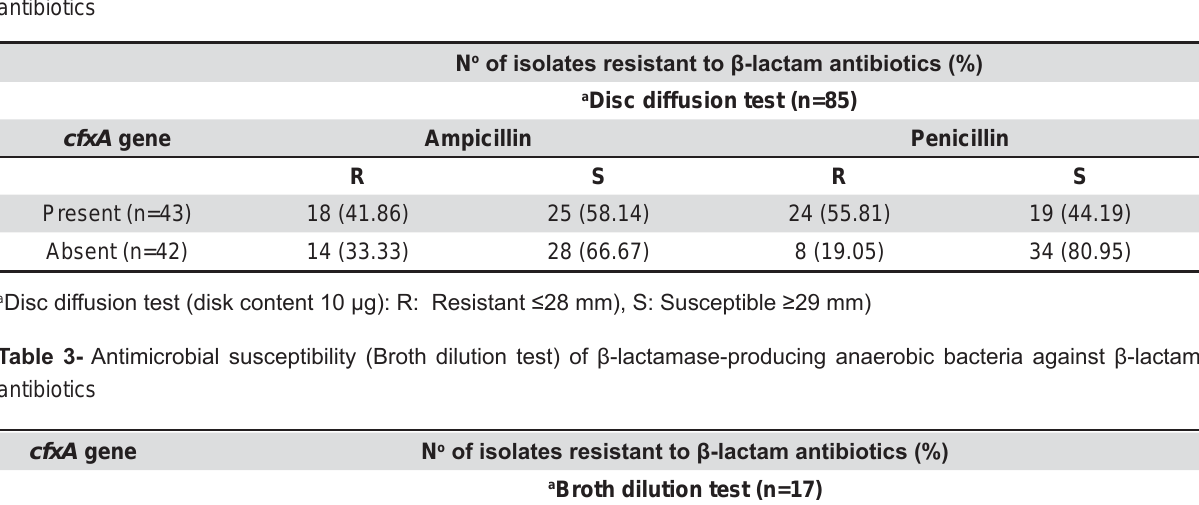
Table 2- (cid:3)(cid:36)(cid:81)(cid:87)(cid:76)(cid:80)(cid:76)(cid:70)(cid:85)(cid:82)(cid:69)(cid:76)(cid:68)(cid:79)(cid:3)(cid:86)(cid:88)(cid:86)(cid:70)(cid:72)(cid:83)(cid:87)(cid:76)(cid:69)(cid:76)(cid:79)(cid:76)(cid:87)(cid:92)(cid:3)(cid:11)(cid:39)(cid:76)(cid:86)(cid:70)(cid:3)(cid:71)(cid:76)(cid:73)(cid:73)(cid:88)(cid:86)(cid:76)(cid:82)(cid:81)(cid:3)(cid:87)(cid:72)(cid:86)(cid:87)(cid:12)(cid:3)(cid:82)(cid:73)(cid:3)(cid:533)(cid:16)(cid:79)(cid:68)(cid:70)(cid:87)(cid:68)(cid:80)(cid:68)(cid:86)(cid:72)(cid:16)(cid:83)(cid:85)(cid:82)(cid:71)(cid:88)(cid:70)(cid:76)(cid:81)(cid:74)(cid:3)(cid:68)(cid:81)(cid:68)(cid:72)(cid:85)(cid:82)(cid:69)(cid:76)(cid:70)(cid:3)(cid:69)(cid:68)(cid:70)(cid:87)(cid:72)(cid:85)(cid:76)(cid:68)(cid:3)(cid:68)(cid:74)(cid:68)(cid:76)(cid:81)(cid:86)(cid:87)(cid:3)(cid:533)(cid:16)(cid:79)(cid:68)(cid:70)(cid:87)(cid:68)(cid:80)(cid:3)